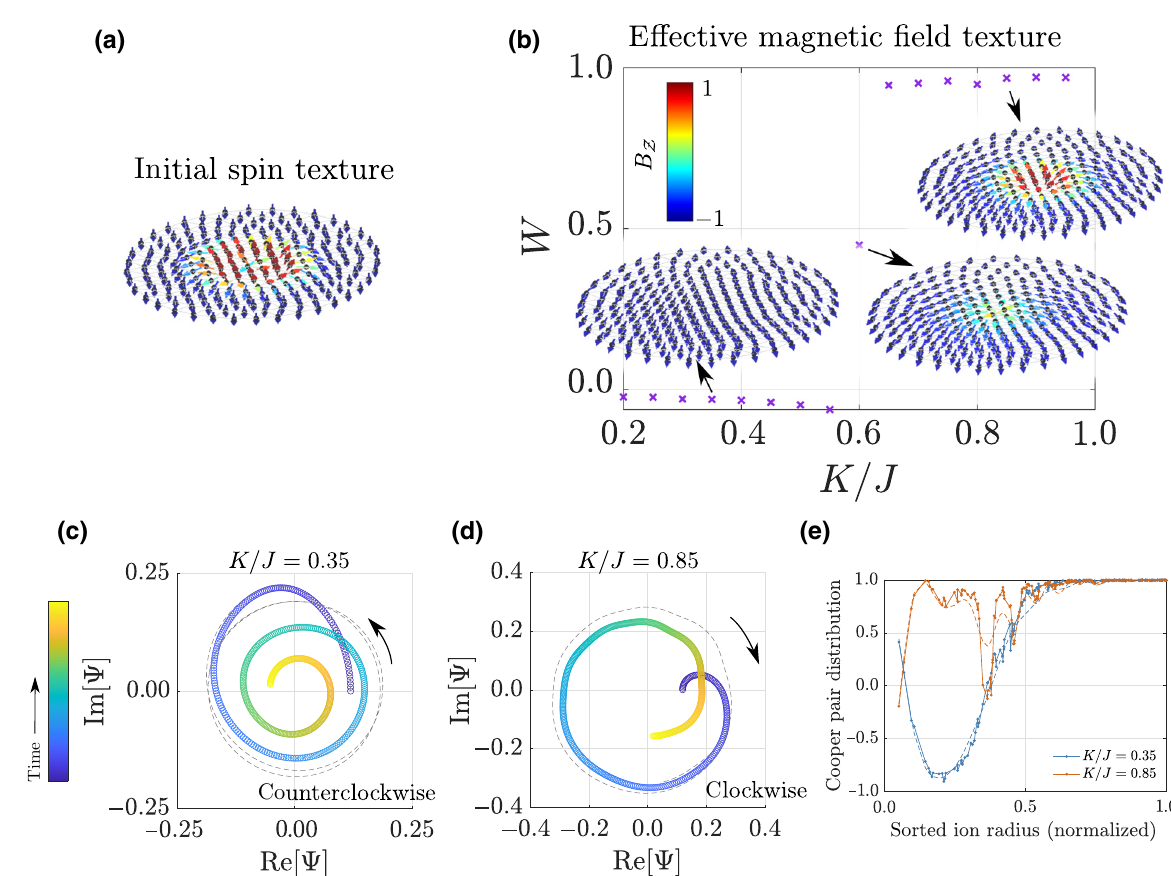
FIG. 3. Inferring topological properties of the dynamical phases. (a) Initial BEC-like spin texture. (b) Mean-field, long-time winding number of the effective magnetic field texture as the relative strength of the single-particle ( K ) and interaction ( J ) terms are varied. In the strong interaction case ( K / J < 0.6), the texture is BEC-like and topologically trivial, while in the weak interaction case ( K / J > 0.6), it is BCS-like and topologically nontrivial. Representative field textures are shown, where each arrow now indicates the unit vector of the effective magnetic field acting at that site, and the color code indicates the normalized B Z component. (c),(d) The sense of rotation of the order parameter in the complex plane reveals the winding number of the underlying magnetic field texture. The topologically trivial (nontrivial) dynamical phase is associated with a counterclockwise (clockwise) rotation of (cid:5)( t ) . While mean-field predicts a stable limit cycle (gray dashed line), DTWA calculations (colored circles) show the order parameter spiraling in towards the origin at long times (plotted here until Jt = 100). The color gradient indicates the arrow of time. (e) The Cooper pair distribution function (CPDF) displays an even (odd) number of zero crossings in the topologically trivial (nontrivial) case. These features are preserved even at times Jt ∼ 100, when the order parameter has decayed considerably due to quantum fluctuations. For comparison, the dashed lines show the CPDF computed using mean-field theory. Crystal parameters are detailed in Appendix B and chiral spin states are initialized according to Appendix